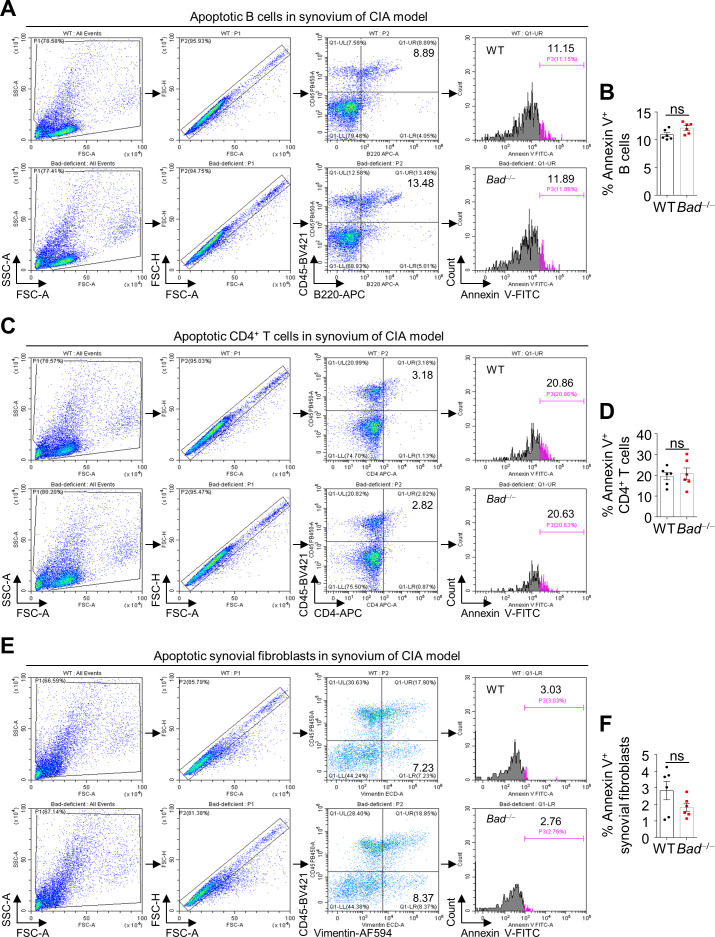
Bad loss does not significantly affect the apoptosis of B cells, CD4+ T cells, or synovial fibroblasts in collagen-induced arthritis (CIA) detected by Annexin V staining.(A, C, and E) Apoptotic synovial B cells (A), CD4+ T cells (C), and fibroblasts (E) from WT and Bad−/− mice in CIA model were analyzed by flow cytometry by staining Annexin V. (B, D, and F) Quantification of the apoptotic B cells (B), CD4+ T cells (D), and fibroblasts (F). All data are presented as mean ± SEM, dots represent individual mice, and n = 6 for each group. Significant difference was analyzed by unpaired Student’s t-test.